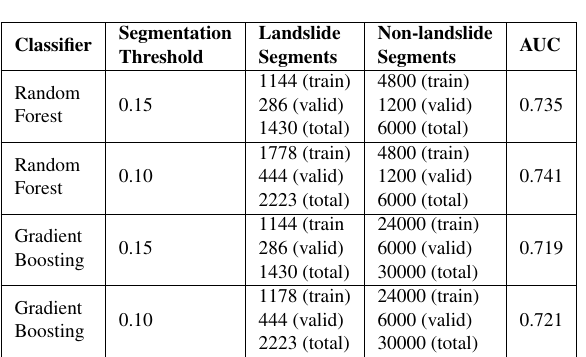
Figure 5: Experimental Setup